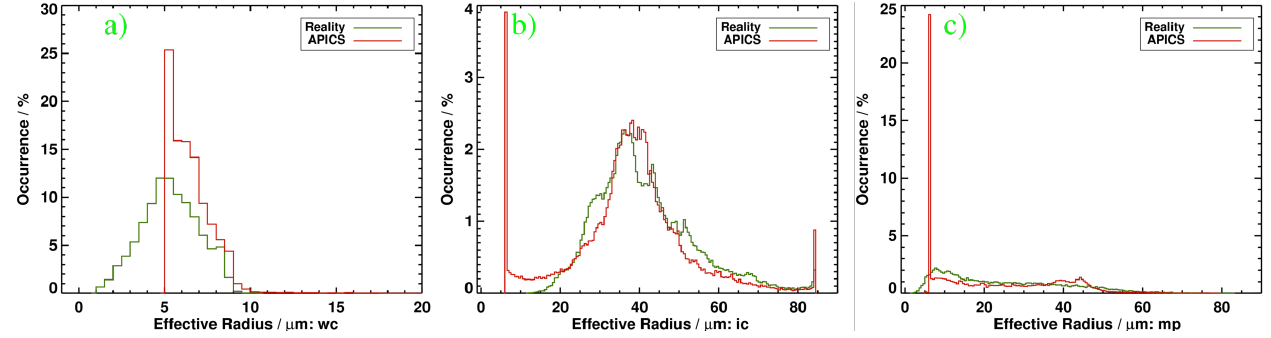
Fig. 12. Histograms of APICS and real cloud effective radius for water (a) , ice (b) and multi-phase clouds (c) .